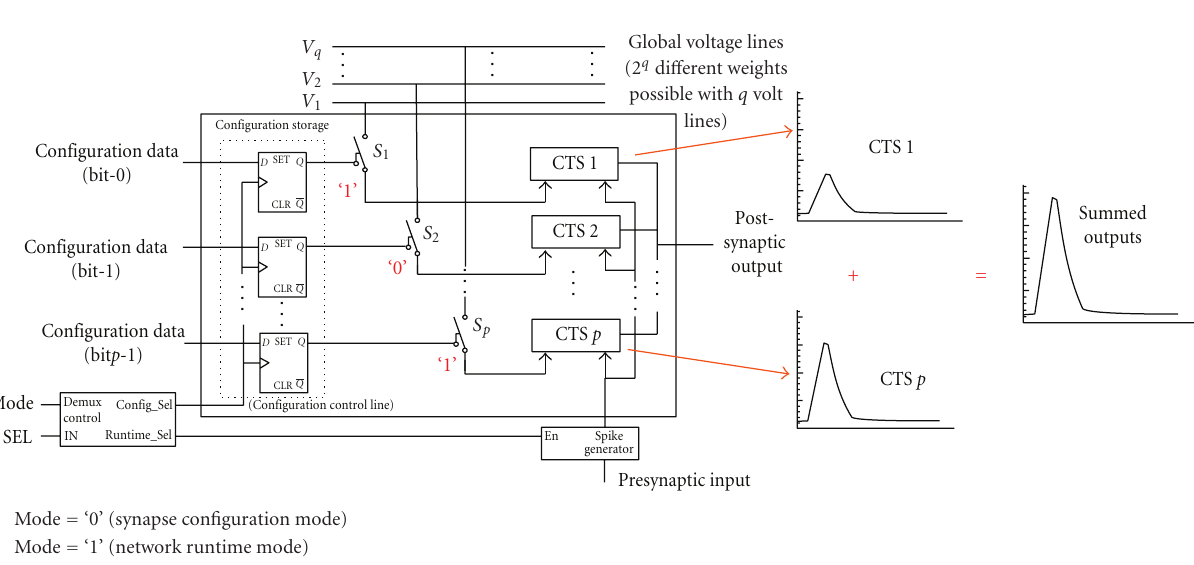
Figure 6: Synapse cell with p